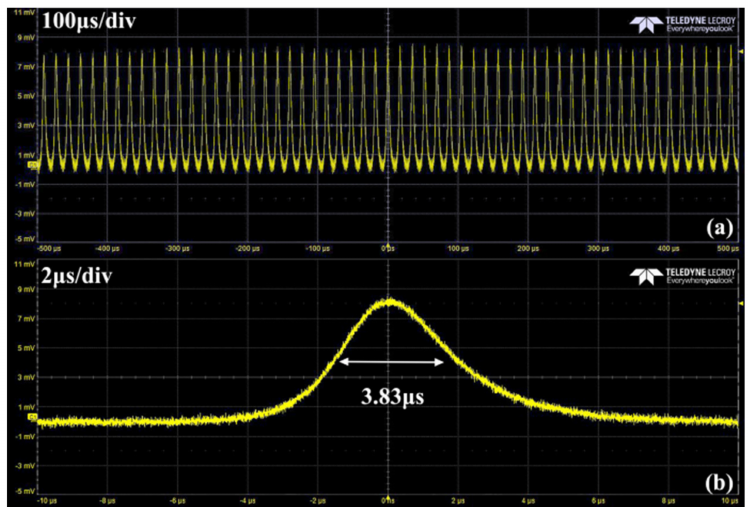
Figure 5. The pulse sequence (T = 2%) recorded at ( a ) 100 µ s/div and ( b ) 2 µ